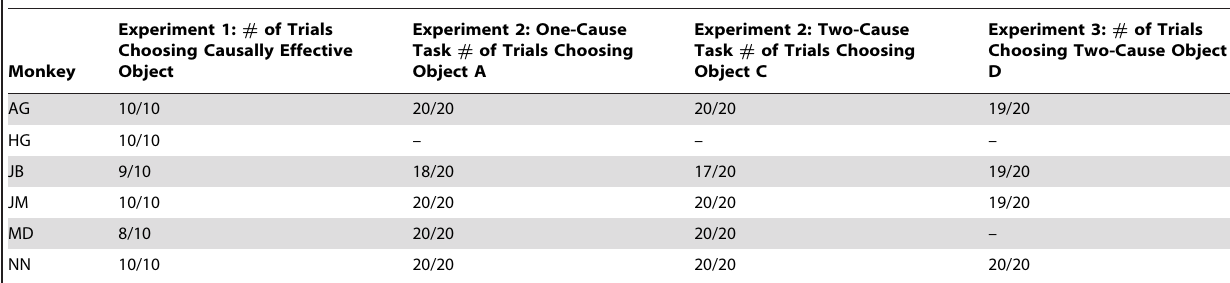
Table 2. Results of Experiments 1–3 across all participants.